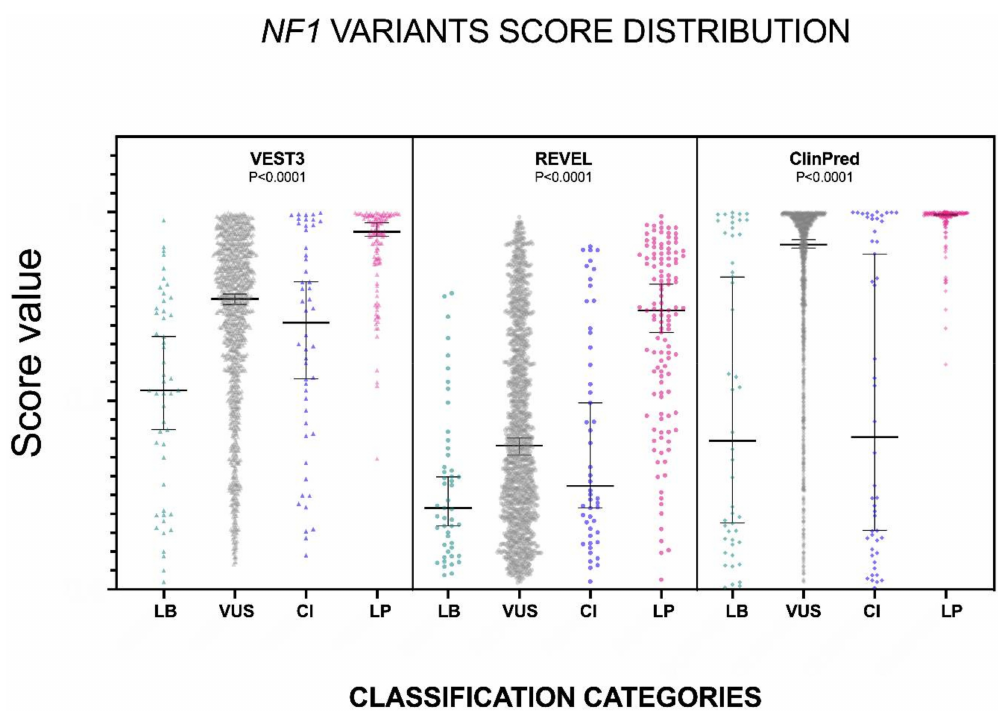
Figure 1. Prediction scores of the three computational methods for the LB (LEANING BENIGN), VUS (variants of uncertain significance), CI (conflicting interpretations), and LP (LEANING PATHOGENIC) NF1 missense variants. Median and 95% confidence intervals are reported for each category. The P value of non-parametric ANOVA is reported for each predictor (Kruskal-Wallis